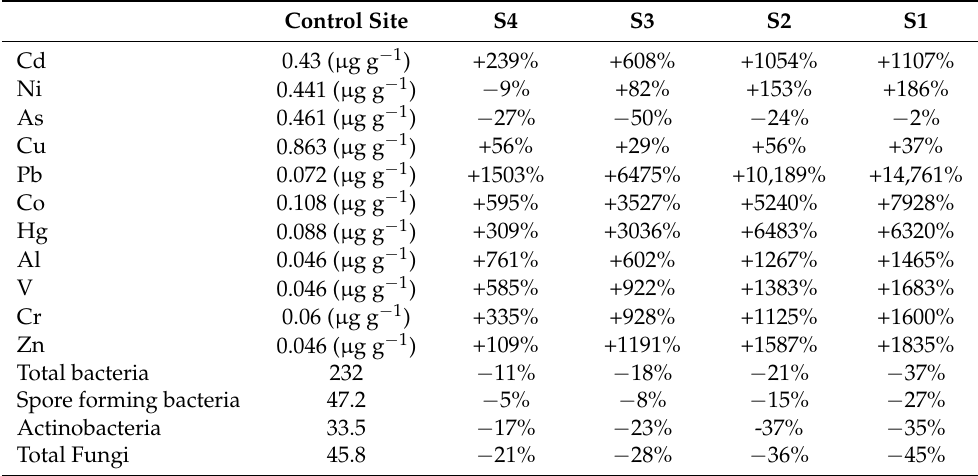
Table 1. Concentration of heavy metals in soils at control experimental sites, and their changes (%) in the polluted sites as compared with the control